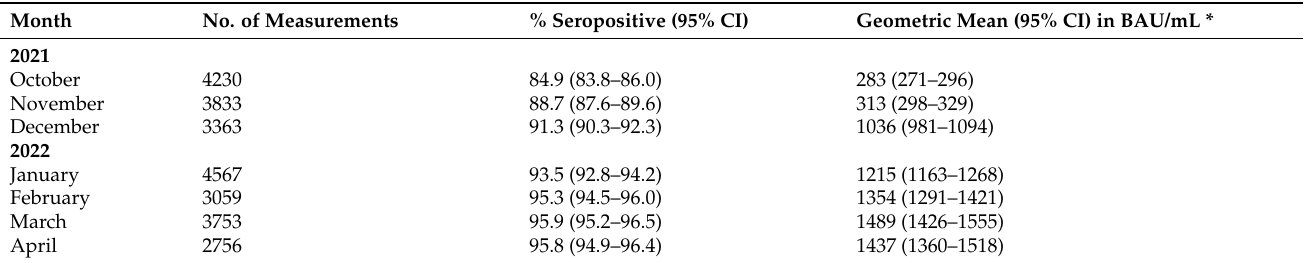
Table 2. Seroprevalence and geometric mean of anti-S IgG antibodies in Tyrolean blood donors aged